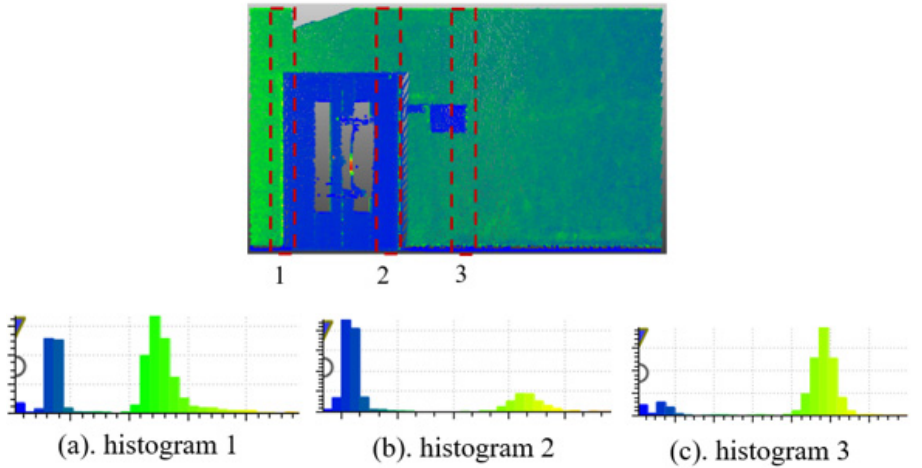
Figure 5. Intensity histograms at three different locations of the moving window: ( a ) histogram 1, ( b ) histogram 2, ( c ) histogram 3.